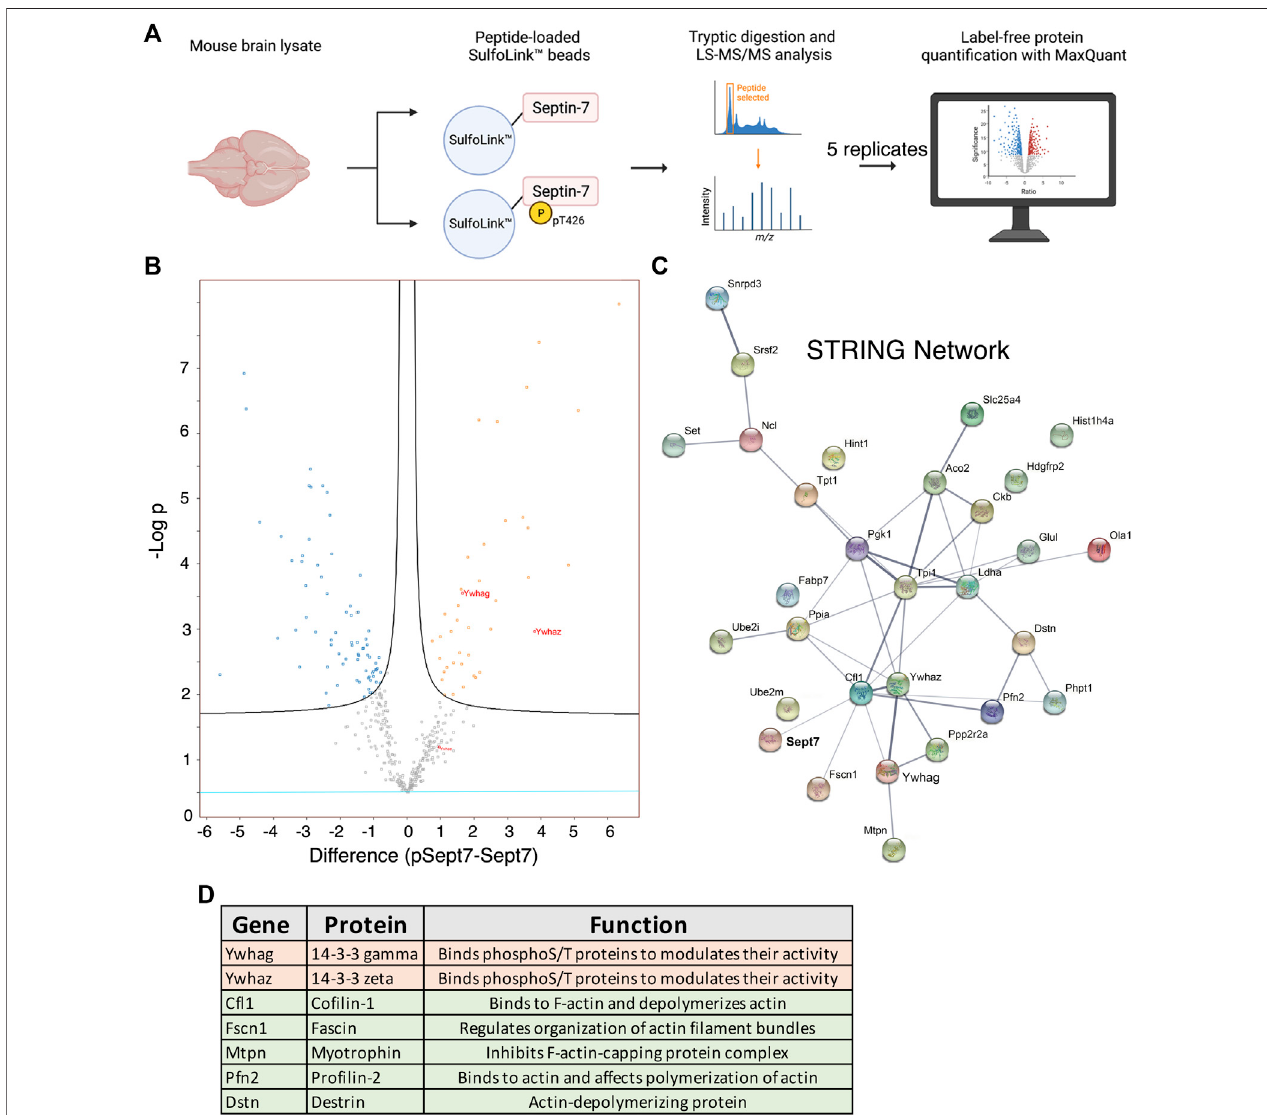
FIGURE 3 | Proteomic identi fi cation of Septin 7 phosphorylation-dependent binding partners. (A) Work fl ow shows the proteomic strategy for identifying Sept7 phosphorylation-dependent binding partners. (B) Volcano plot displays the difference in association of proteins with phosphorylated (pT246) Sept7 versus unphosphorylatedSept7basedon fi vereplicatepulldowns.14-3-3proteinisoformsarelabeled inred. (C) Theprotein – proteinassociationnetworkofcandidatepSept7 interaction partners. The STRING network of identi fi ed proteins that signi fi cantly associate with phosphorylated Sept7 tail (pT426) versus non-phosphorylated Sept7 tail. Network nodes represent interacting proteins, and network edges indicate both functional and physical protein associations. Strength of the association is denotedbythethicknessoftheedges. (D) 14-3-3familyofproteinsaswellasseveralactinbindinganddepolymerizingproteinswerefoundtosigni fi cantlyassociatewith Sept7 when phosphorylated at